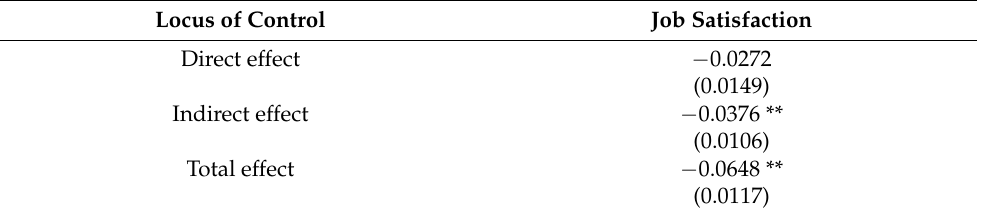
Table 5. Direct effect and indirect effect-locus of control, work values ethic on job satisfaction. Locus of Control Job